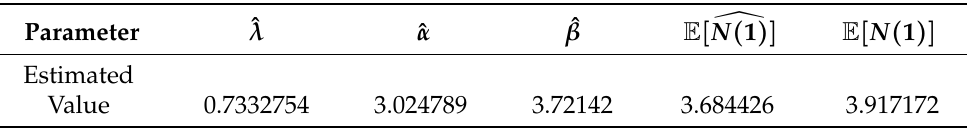
Table 2. Hawkes Estimated Parameters and their Empirical and Theoretical Estimated Number of Arrivals of Group 2.